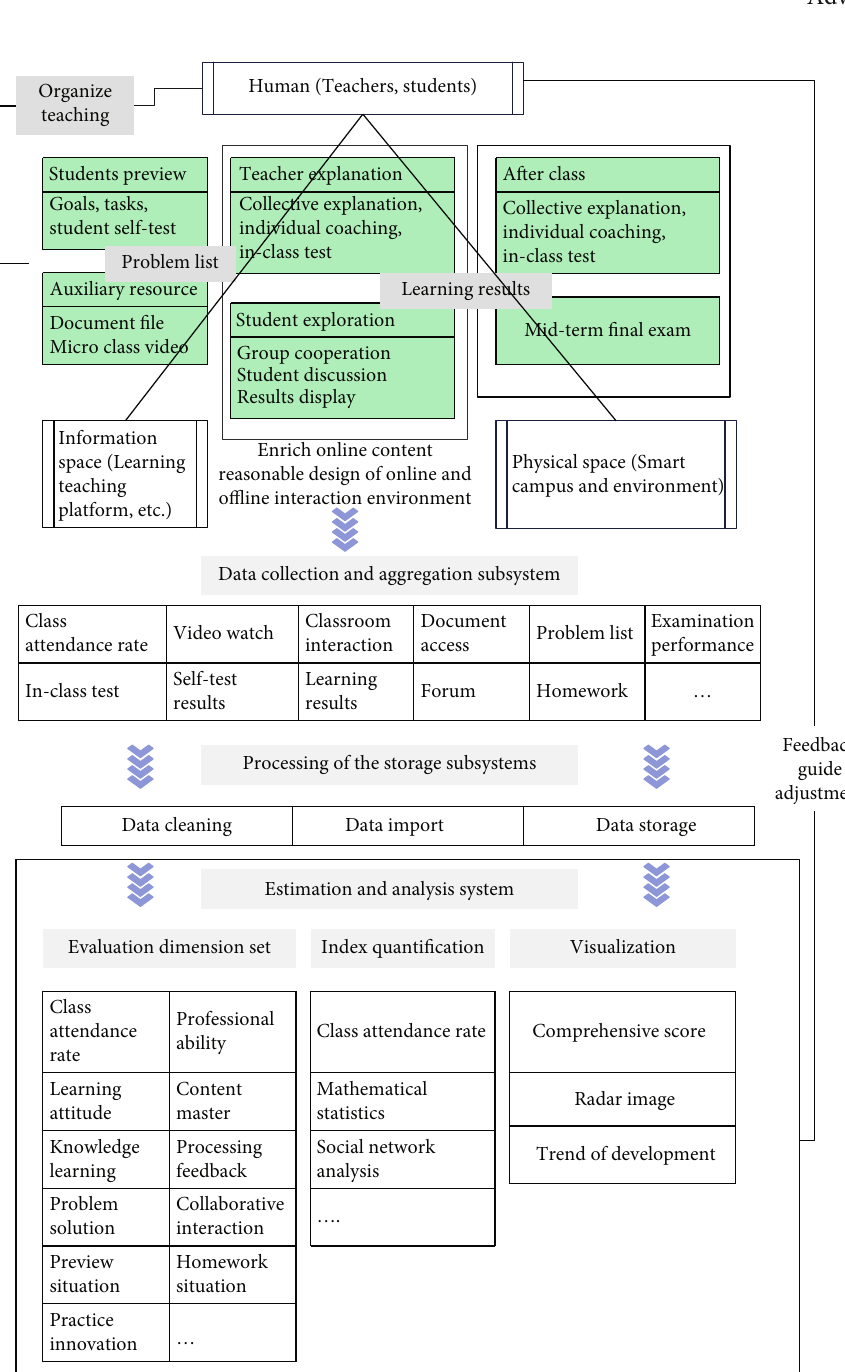
Figure 5: Design model of the LE evaluation system of